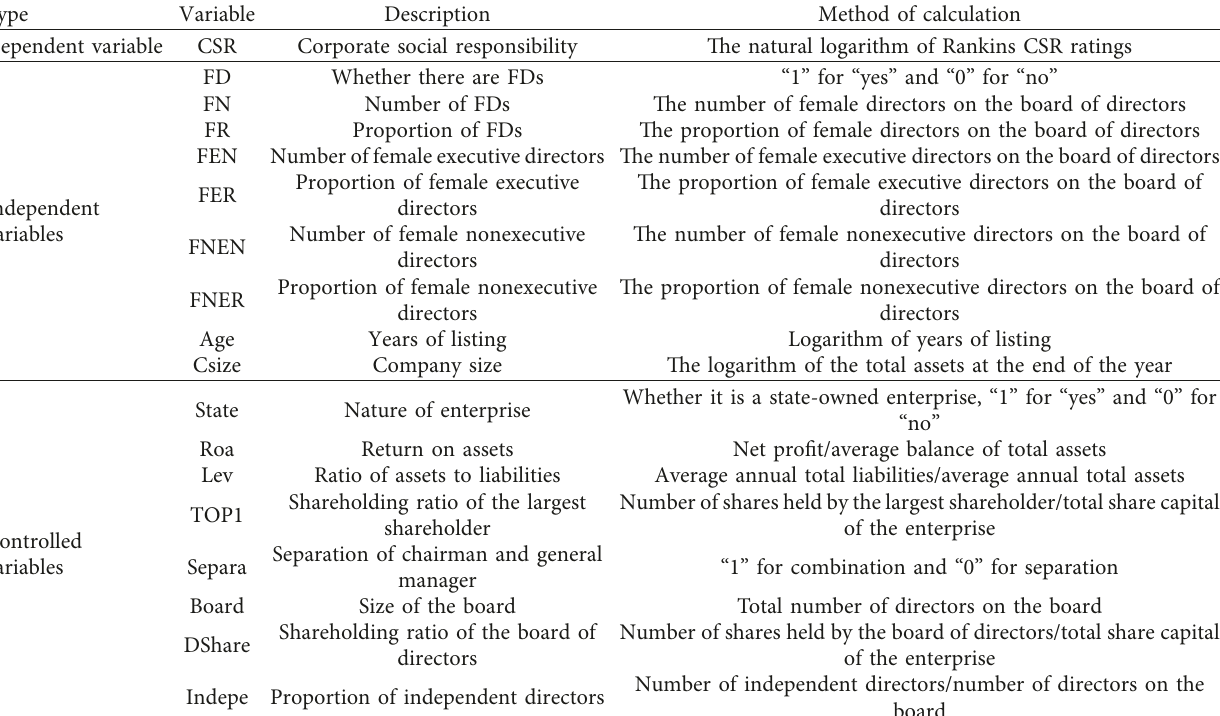
Figure 5: BP neural network prediction results. Table 1: Definition of